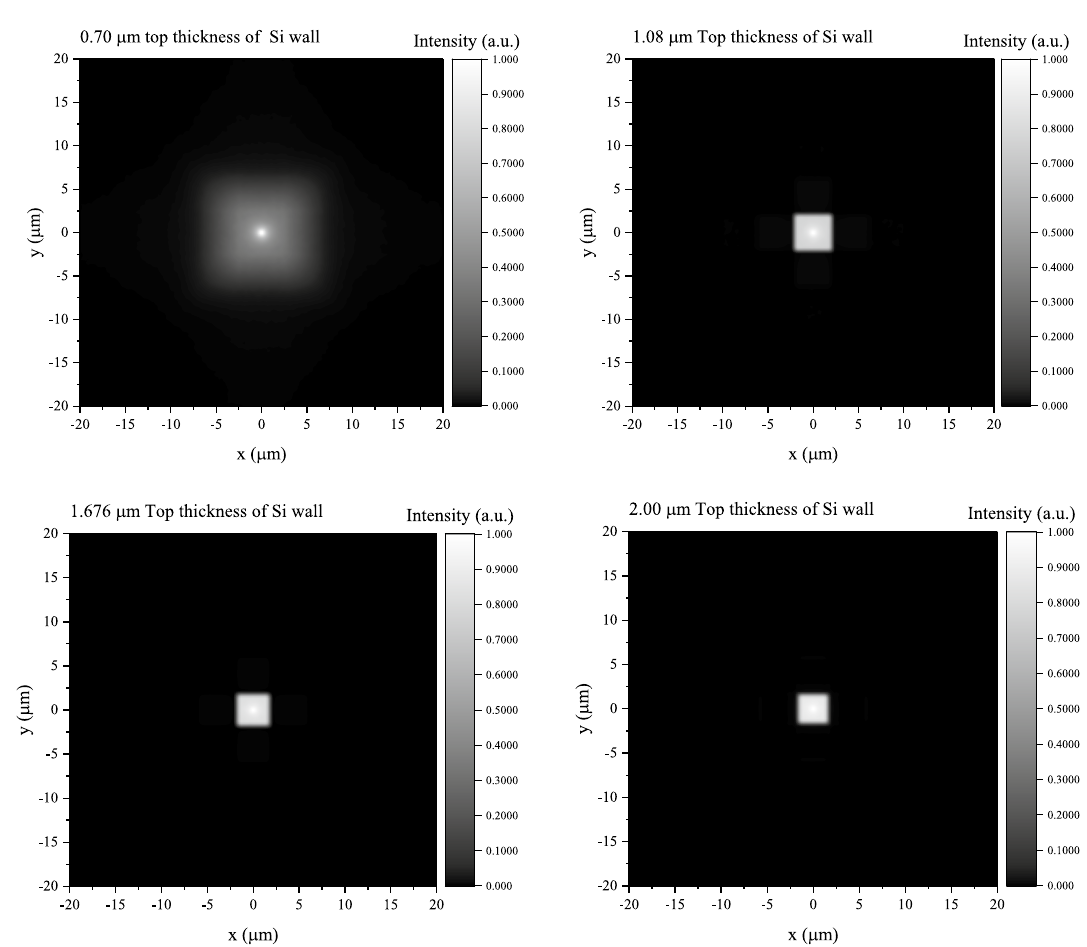
Figure 5. Normalized two-dimensional intensity distribution of BLO with the t Si of 0.70, 1.08, 1.68 and 2.00 μm,